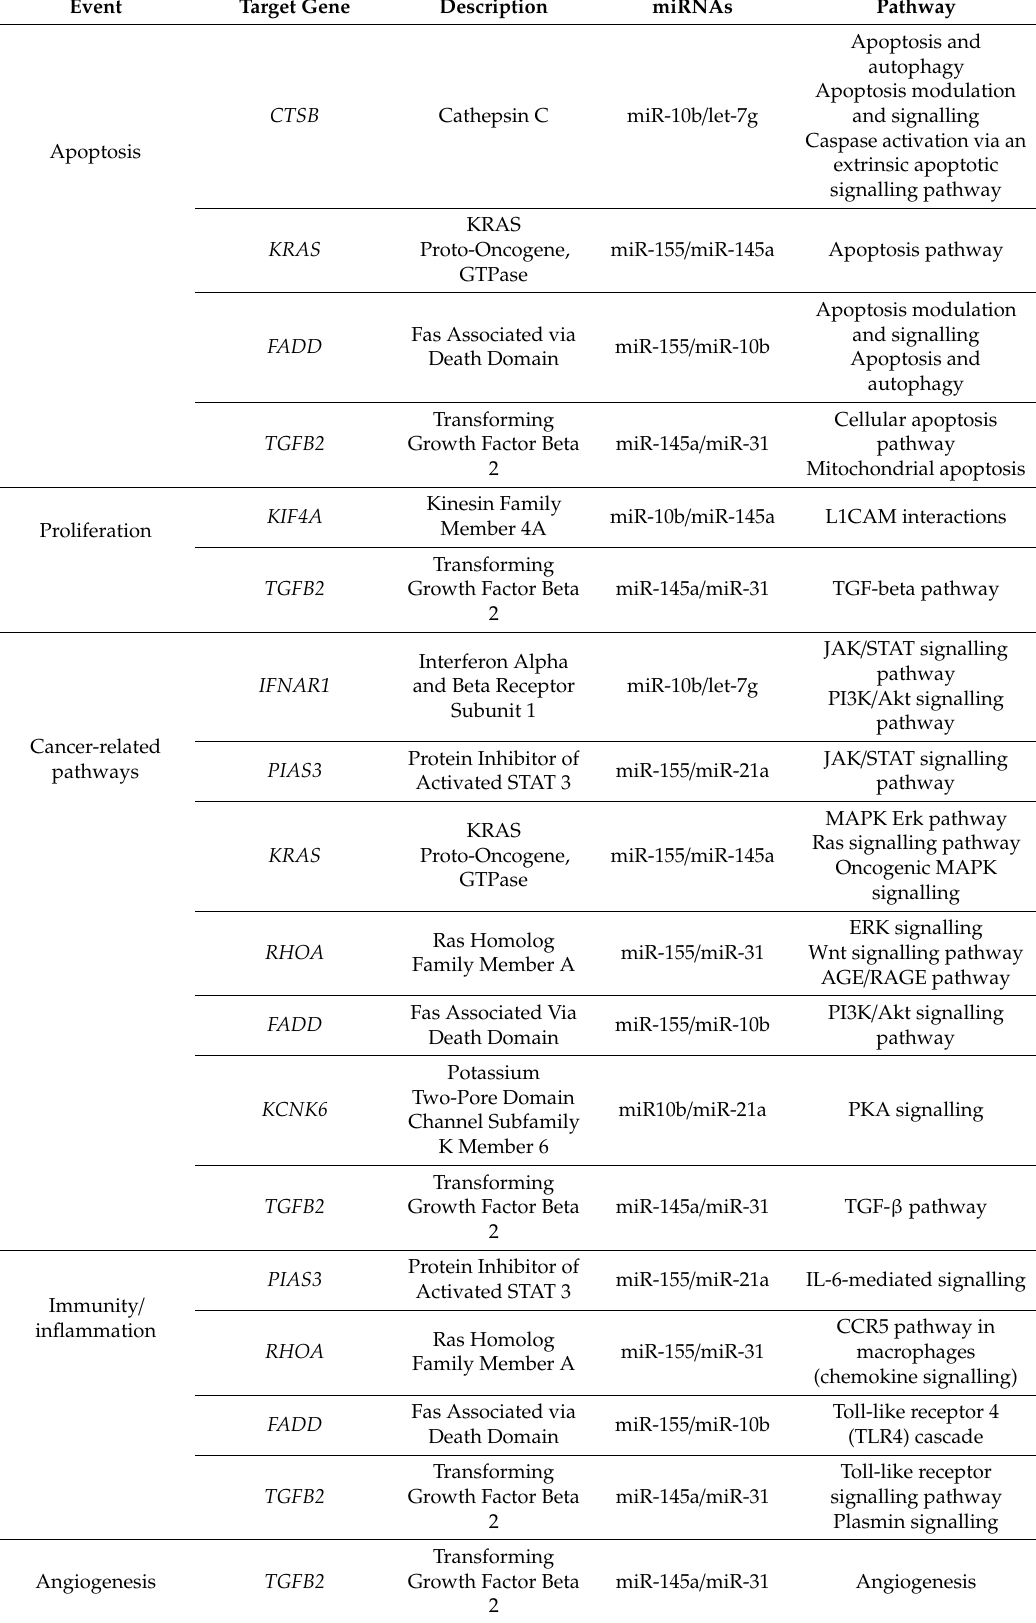
Table 3. Common target genes of the evaluated miRNAs and their